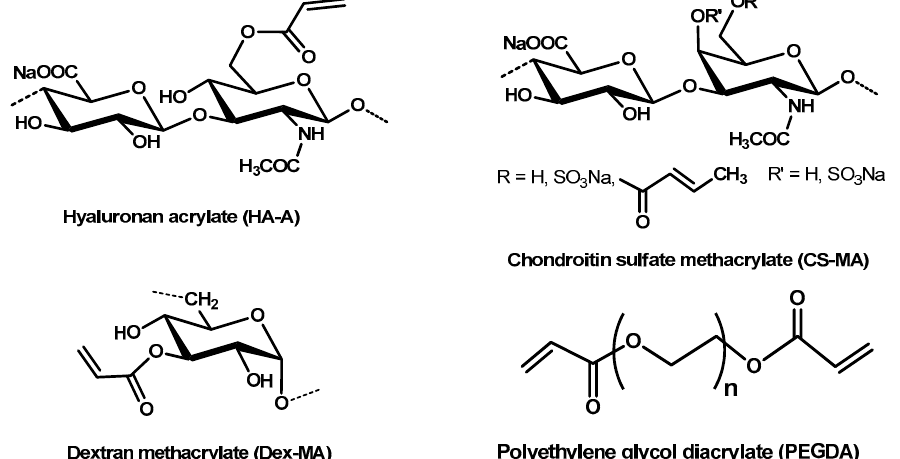
Figure 6. Chemical structures of GAG, polysaccharide (dextran), and crosslinker components used for cryogel preparations.